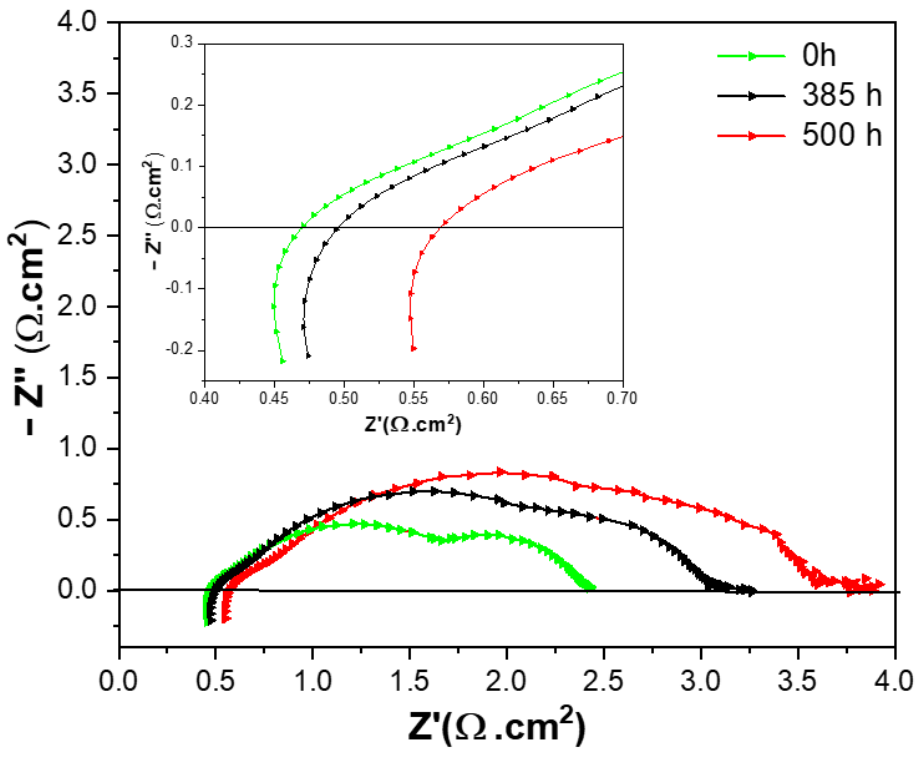
Figure 9. Impedance spectra of the cell at 700 °C and at various operation times over long-term operation (0 h, 385 h, and 500 h).